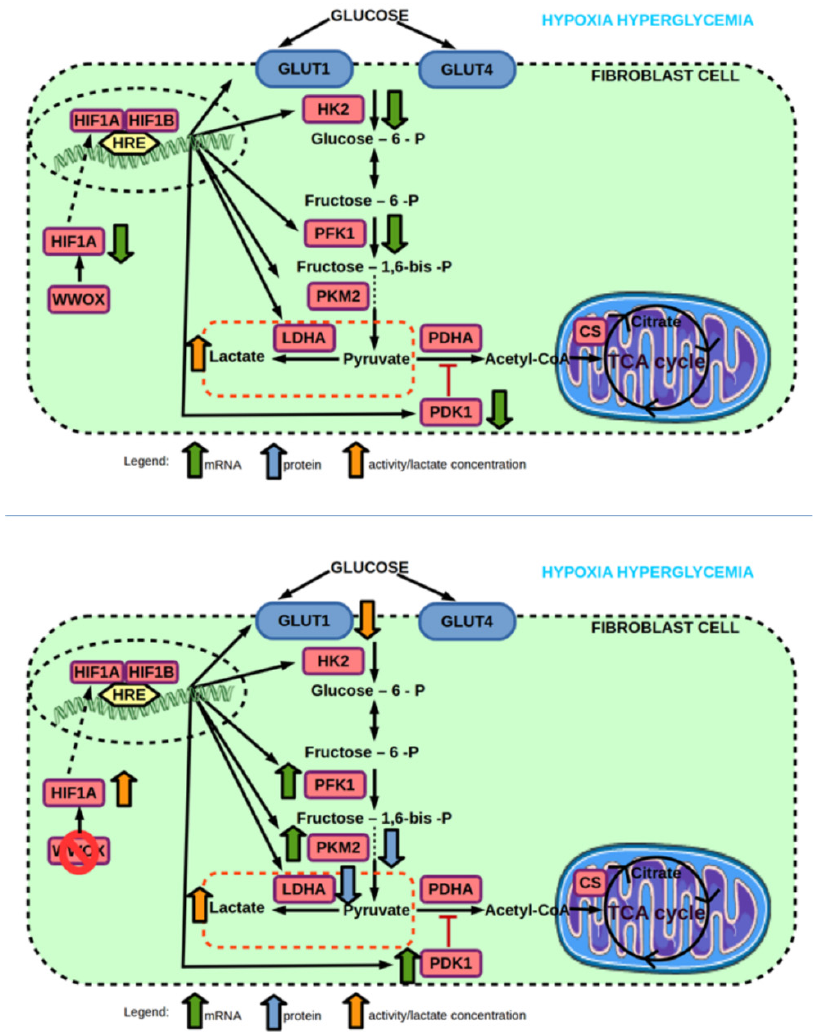
Figure 11. ( top ) Effect of hyperglycemia on mRNA and protein expression, and enzyme activity of genes involved in glucose transport and glycolysis pathway of 1BR.3.N fibroblast cell line in hypoxia. ( bottom ) Effect of WWOX KO on mRNA and protein expression, and enzyme activity of genes involved in glucose transport and glycolysis pathway of 1BR.3.N fibroblast cell line in hypoxia hyper- glycemia condition. Based on free images from Servier Medical Art; CC BY 3.0.